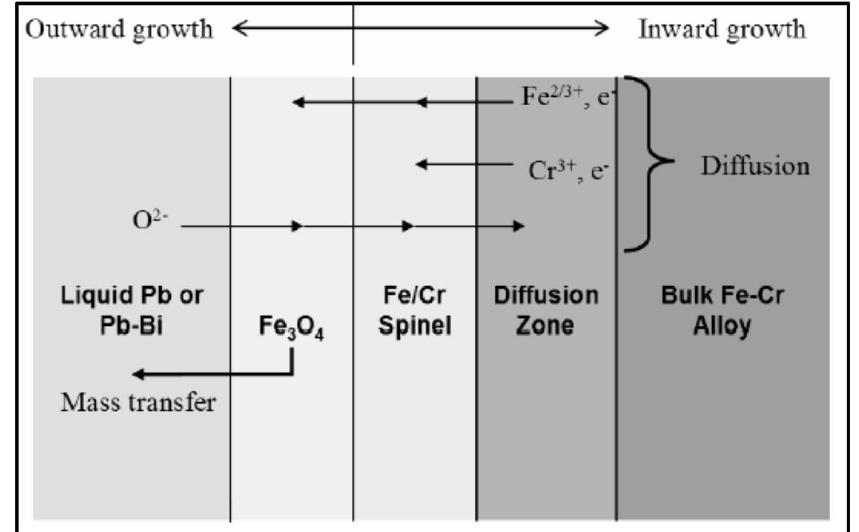
Figure 2. Corrosion mechanism of F/M steel in LBE [35].